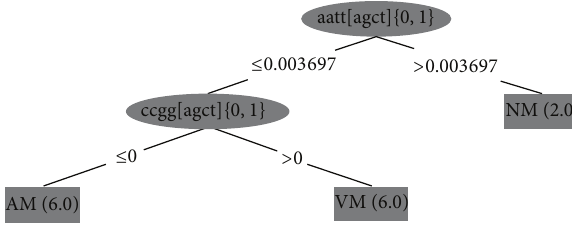
Table 2: Table of unique patterns in each region.